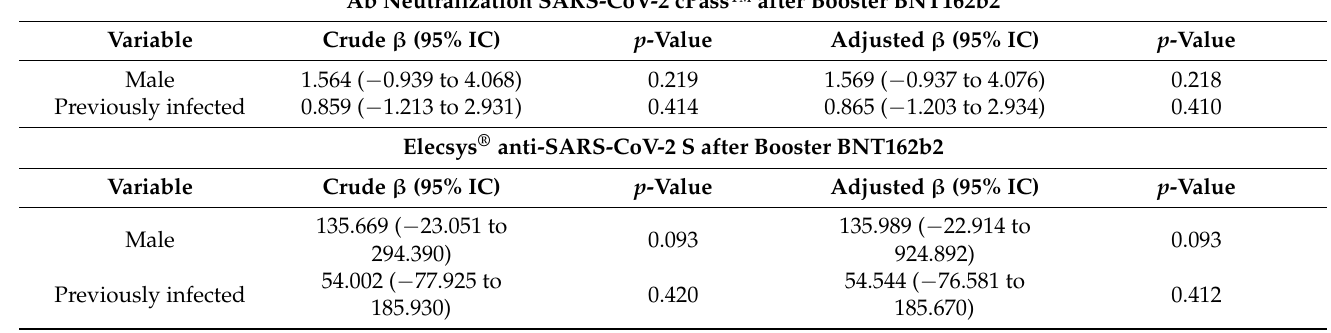
tion SARS-CoV-2 cPass™, Elecsys ® anti-SARS-CoV-2 S-RBD after booster BNT162b2.